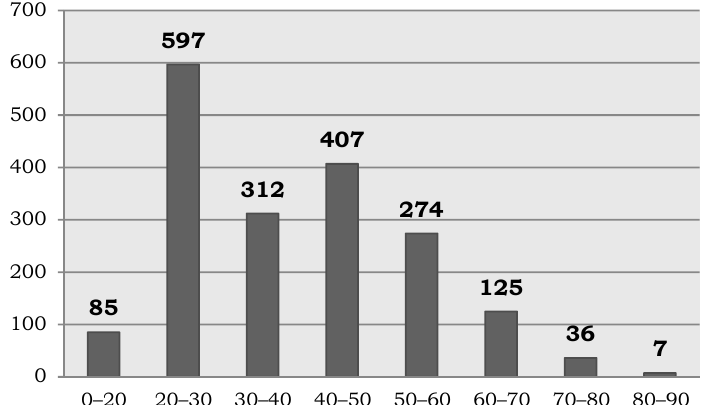
Figure 6. Distribution by age of the donors incorporated into the Andalusian Registry of Donors for Biomedical Research since its creation in 2015.